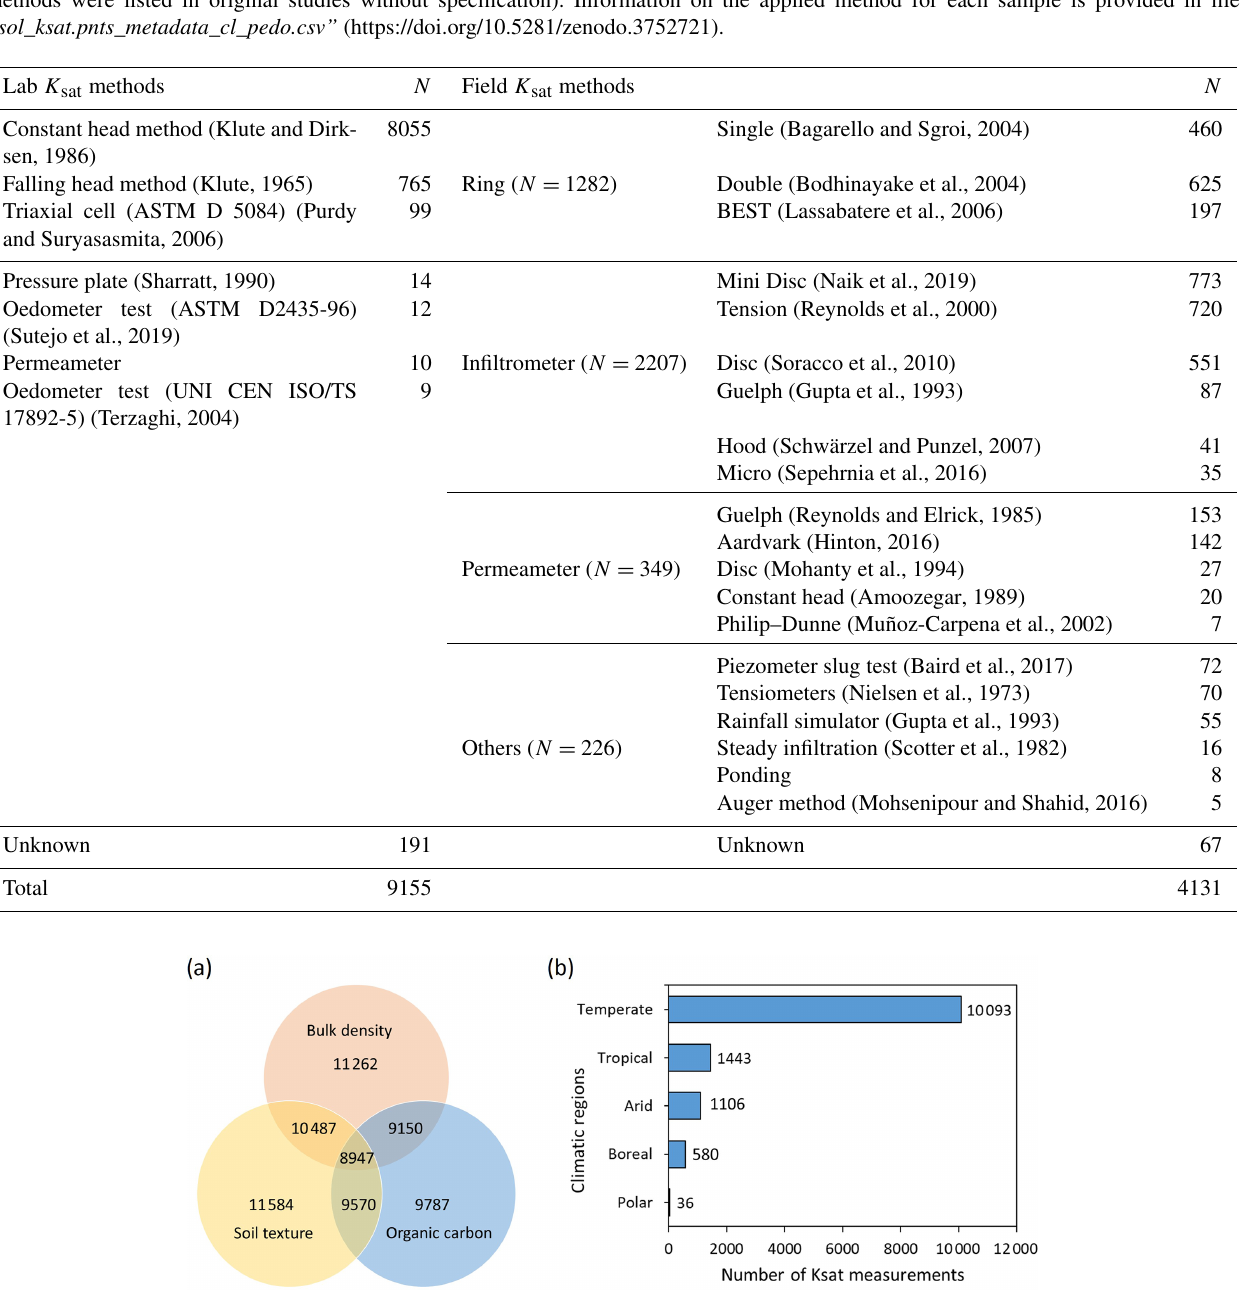
Table 4. Instruments and methods used to estimate K sat . A key reference with further details is given for all methods. The field methods are subdivided into different subcategories (in some cases, “ponding” in the field methods or “permeameter” in the lab methods were listed in original studies without specification). Information on the applied method for each sample is provided in file